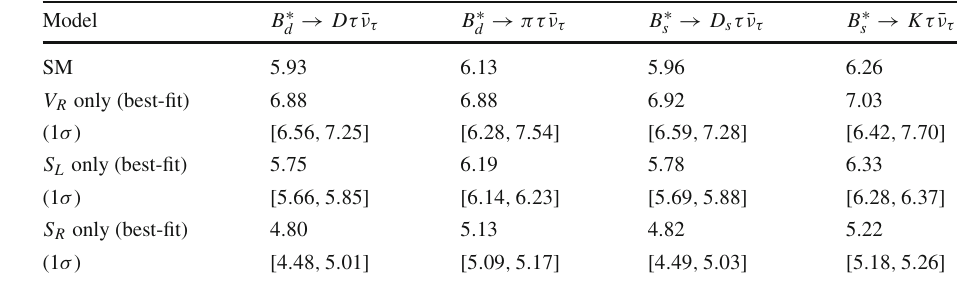
GeV 2 ) of the zero crossing of forward–backward asymmetries → P τ ¯ ν τ decay modes of B ∗ d , s in the SM and in the presence of individual V R , S L , R